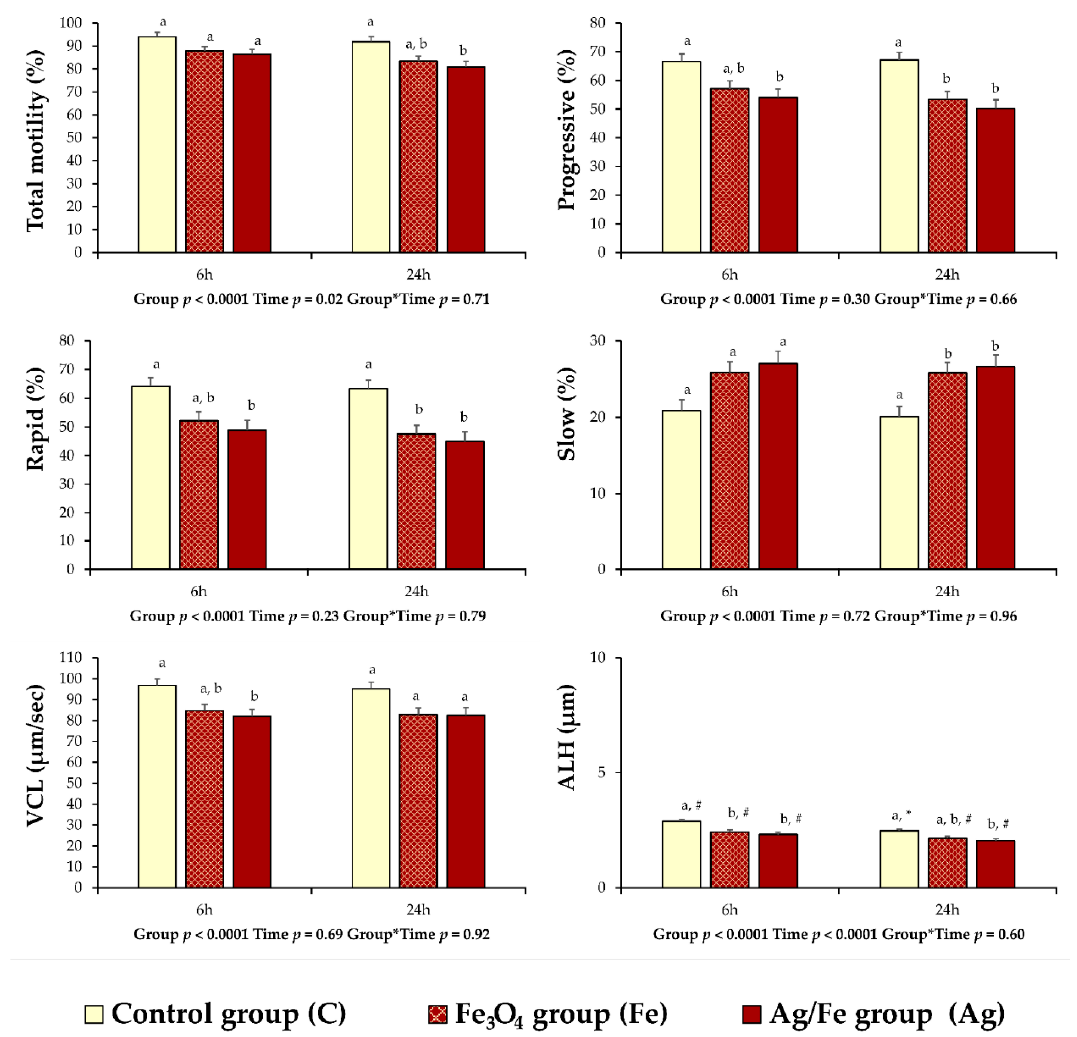
Figure 3. CASA (computer assisted sperm analysis) motility and kinetics variables of liquid extended ram semen ( n = 21) preserved at 15 °C for 6 and 24 h post treatment with Fe 3 O 4 or Ag/Fe nanoparticles (NPs). Control group (C): Extended ram semen samples-no treatment; iron oxide group (Fe): Extended ram semen with Fe 3 O 4 NPs (3.072 mg Fe 3 O 4 per mL of semen); silver group (Ag): Extended ram semen with Ag/Fe NPs (2.048 mg Ag/Fe per mL of semen). Values are expressed as LSmeans ± standard error of the mean (SEM). Differences at statistical level between groups are noticed by different superscripts (a, b). Significant differences between evaluation times within each experimental group are depicted by different symbols (#, *).